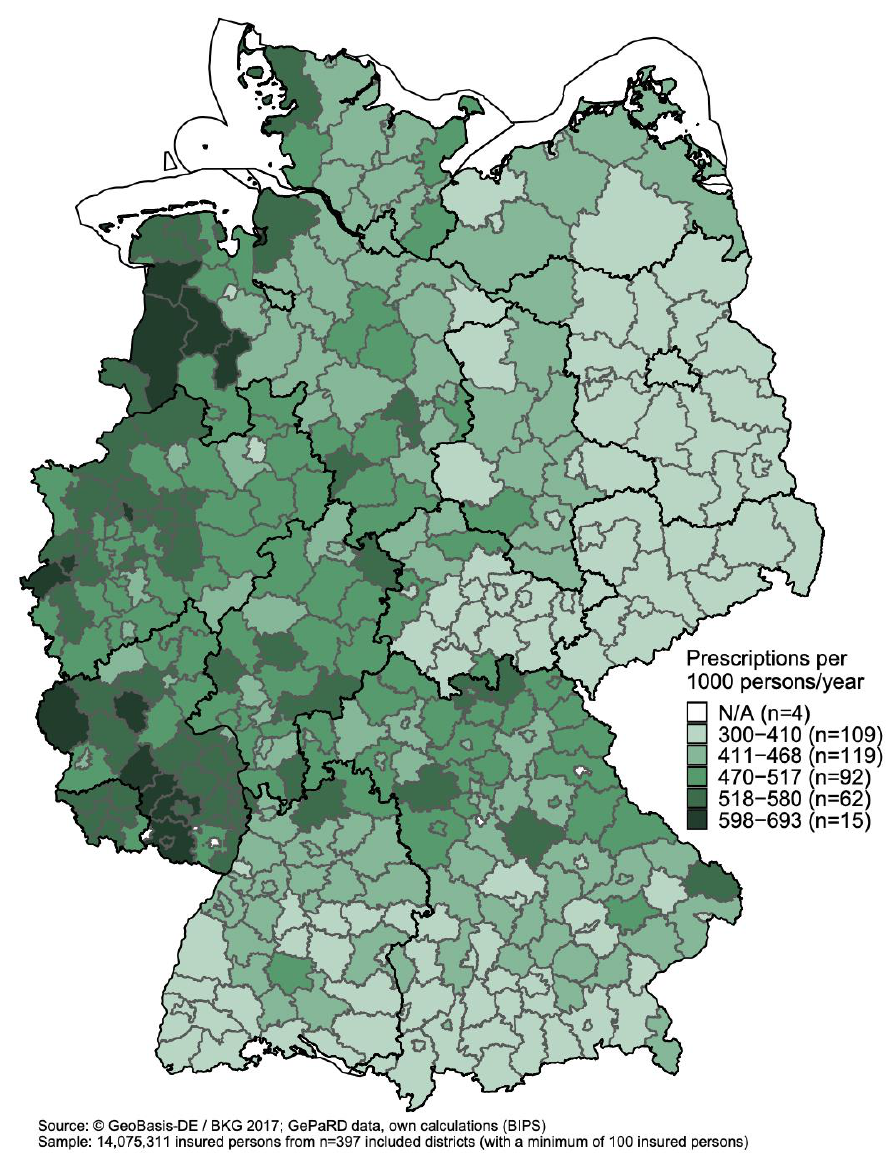
Figure 3. Age- and sex-standardized prescription rates (prescriptions per 1000 persons/year) of an- tibiotics among adults aged ≥ 18 years by district in 2018. Regional variations in antibiotic prescribing based on the prescription prevalence in the different age groups are shown and described in the Supplementary Materials (Fig- ures S7 – S9 and Text S1).